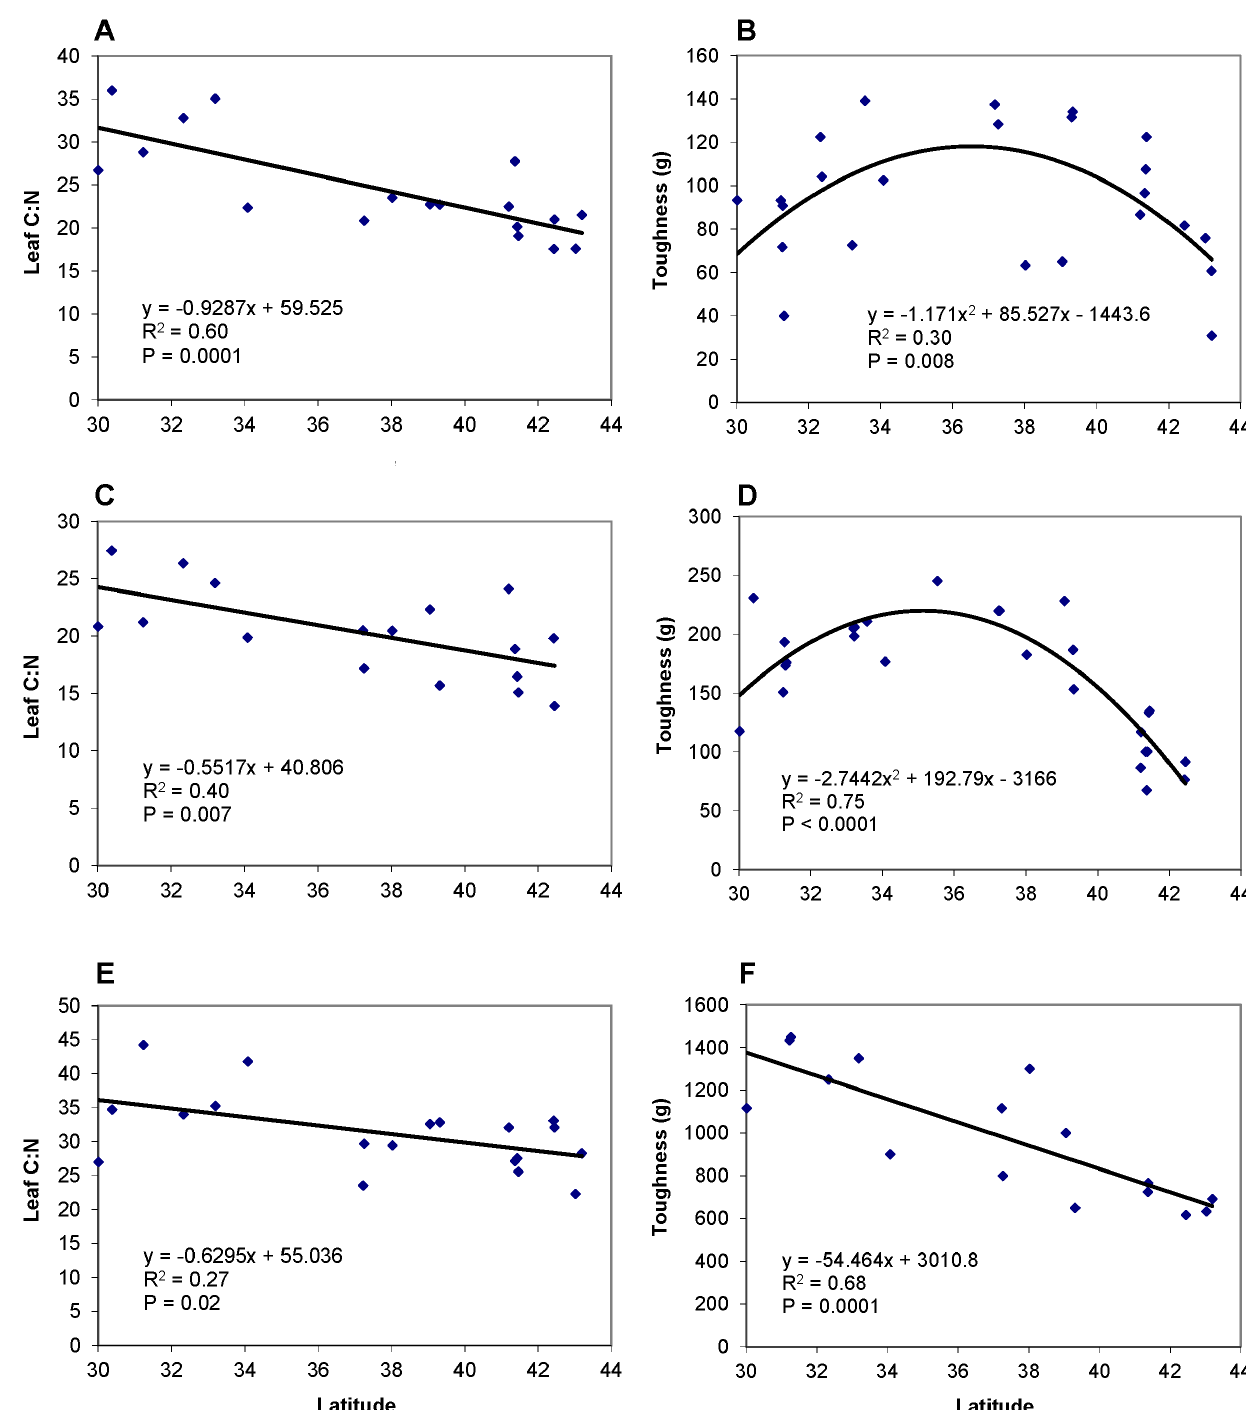
Figure 2. Patterns of plant traits in the field. Leaf C:N and toughness of Solidago sempervirens (A, B), Iva frutescens (C, D) and Spartina alterniflora (E, F) versus latitude. Each point represents a single study site.